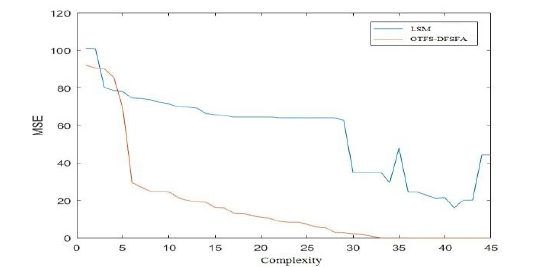
Figure 2. Fitting effect diagram for the two algorithms